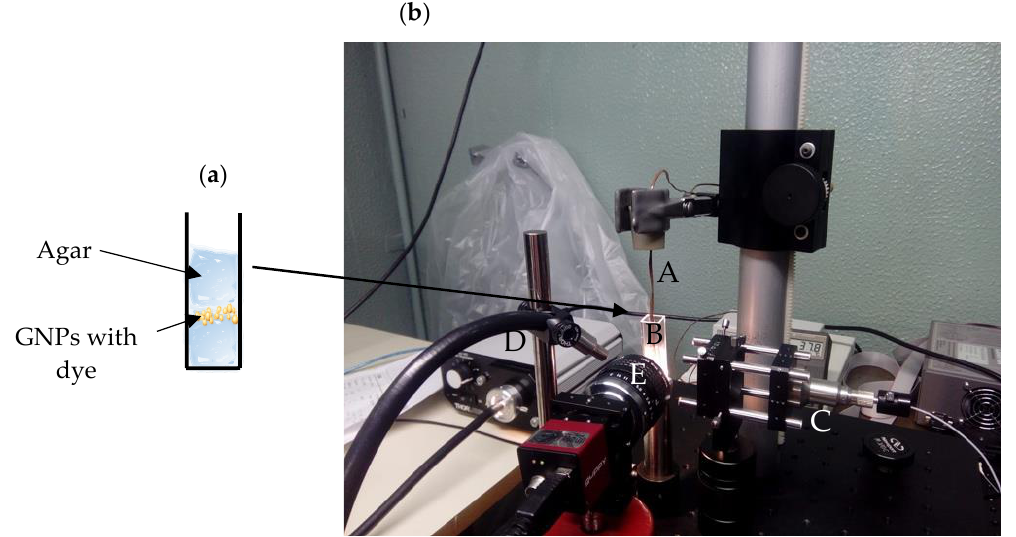
Figure 2. ( a ) Schematic representation of HAOA-coated GNPs included into the phantoms in cuvette and ( b ) irradiation apparatus. A — thermocouple, B — cuvette, C — laser delivery system, D — light source and E — digital camera.